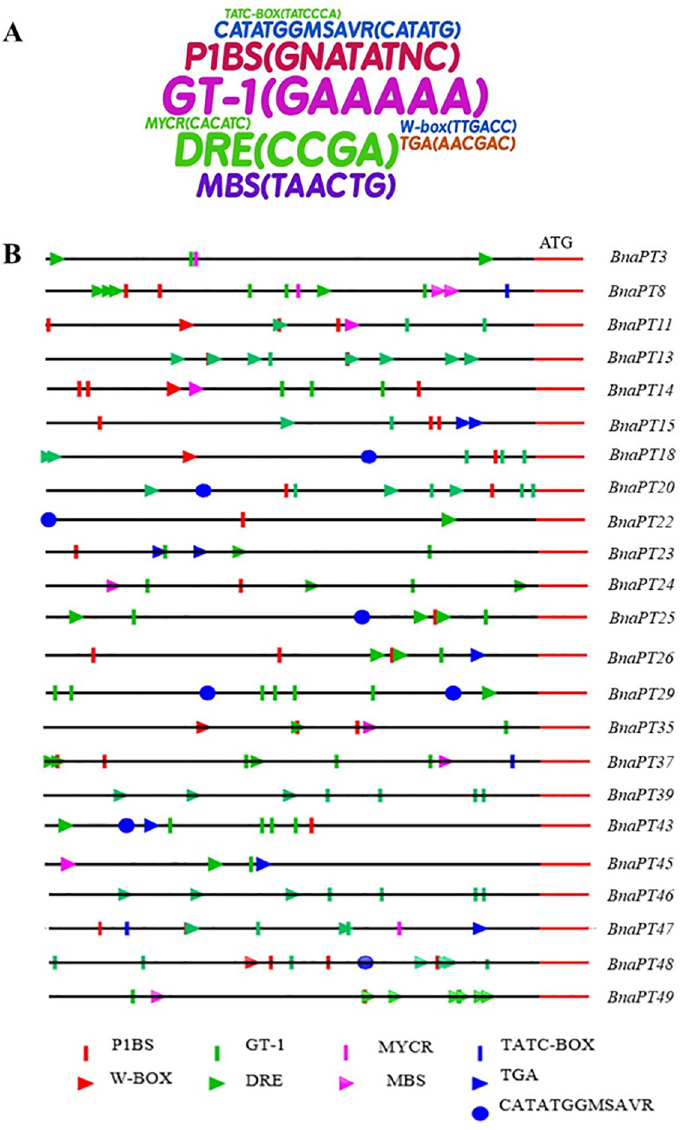
Fig 8. Cis -elements in the 2.0-kb promoter regions of the PHT1 family genes in Brassica napus . (A) Enrichment of the cis -elements in the promoter sequences of BnaPT s. The size of the sequence represents the frequency of the cis - elements in the promoter regions. (B) Distribution of nine cis -elements in the promoters of 23 PHT1 family members. These cis -elements are associated with P homeostasis (P1BS and W-BOX), salt stress response (GT-1 and DRE), drought stress response (MYCR and MBS), and auxin response (TATC-BOX, TGA and CATATGGMSAVR).